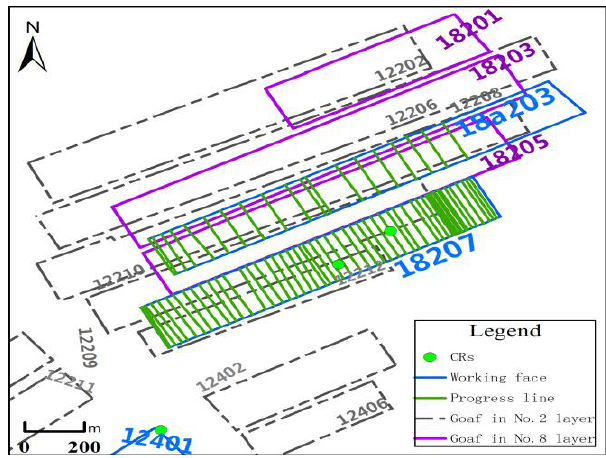
Figure 8. Working face 18207 and other vicinity working faces. Green points are corner reflectors. Blue lines indicate the working face while green lines are the progress line. Several abandoned mines (goaf) in other layers were shown as well. Image center coordinates: 37°53'32.51"N,